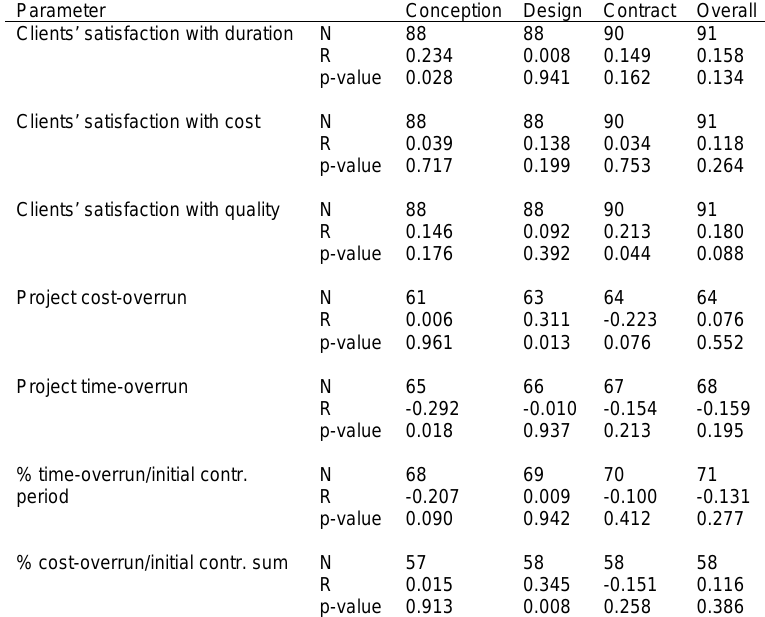
Table 6: Results of the Spearman test of correlation between the level of project